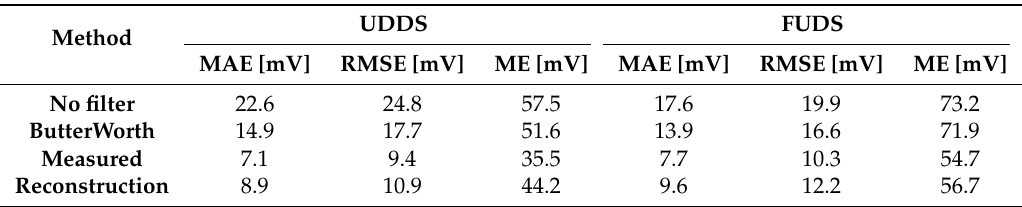
Table 2. Error statistics of different voltages under the UDDS and FUDS tests at 25 ◦ C. MAE =